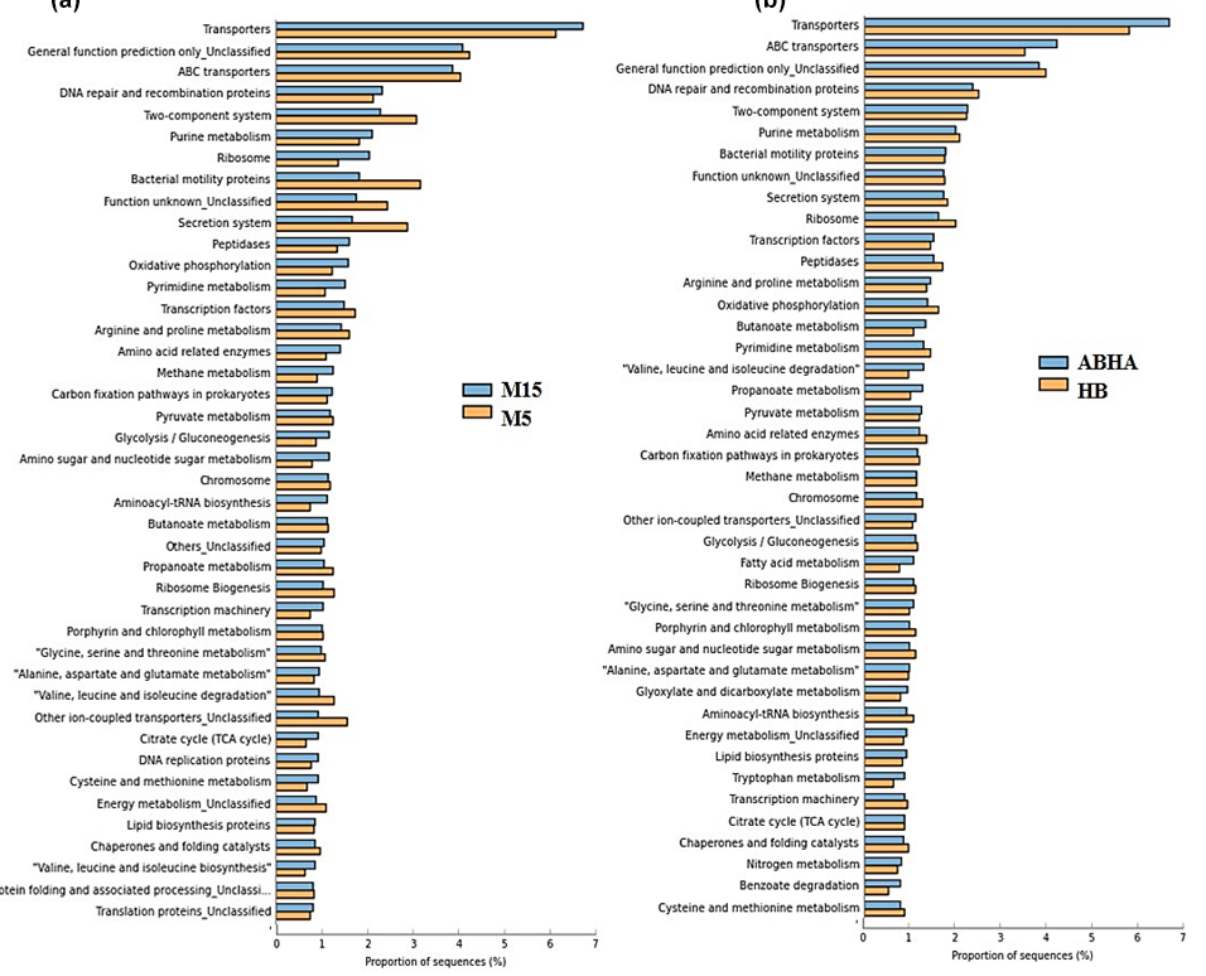
Figure 6. Statistical comparison (Welch’s t test) of the predicted function gene abundance between M5 and M15 samples obtained from Muzahmiya (a) and between ABHA and Hafar Al Batin (b) . P -value correction; P< 0 .